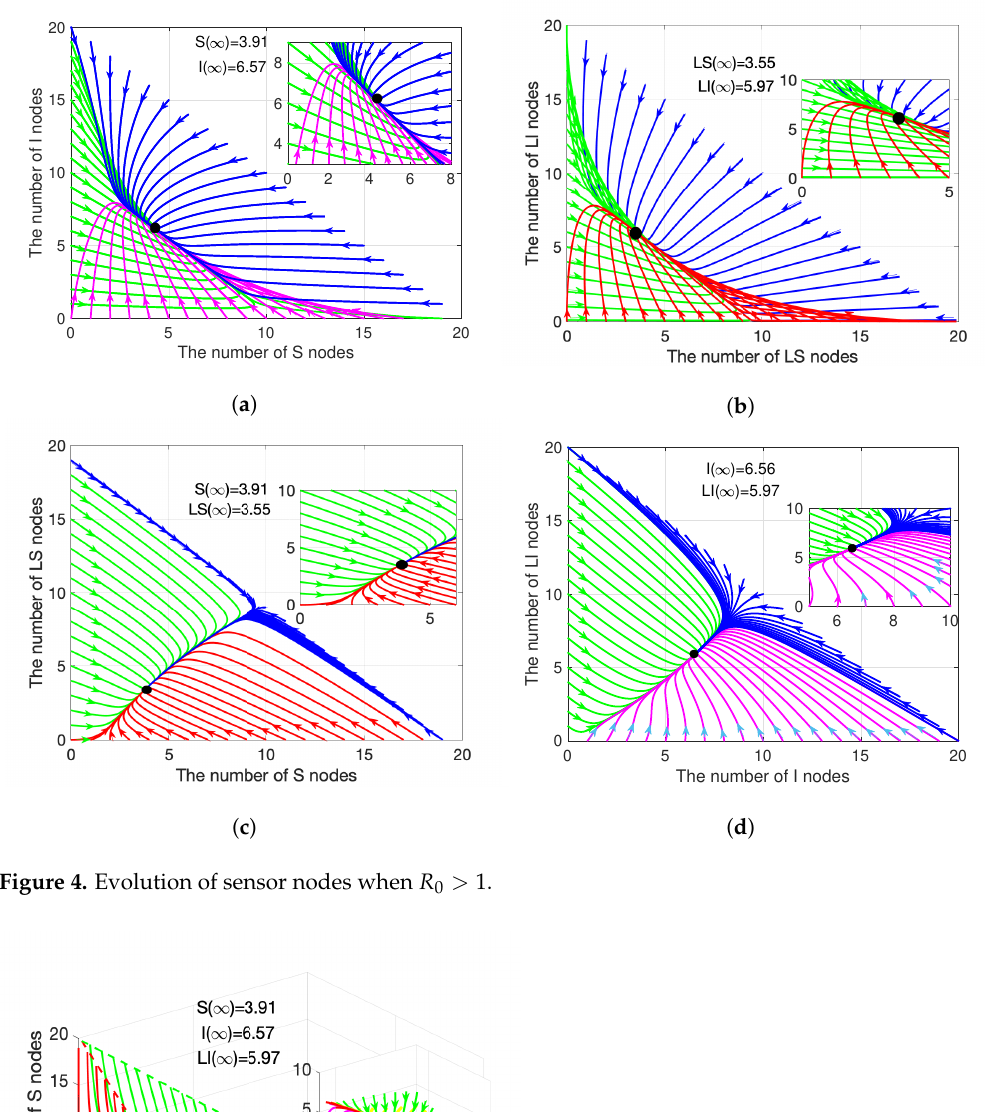
Figure 4. Evolution of sensor nodes when R 0 > 1.